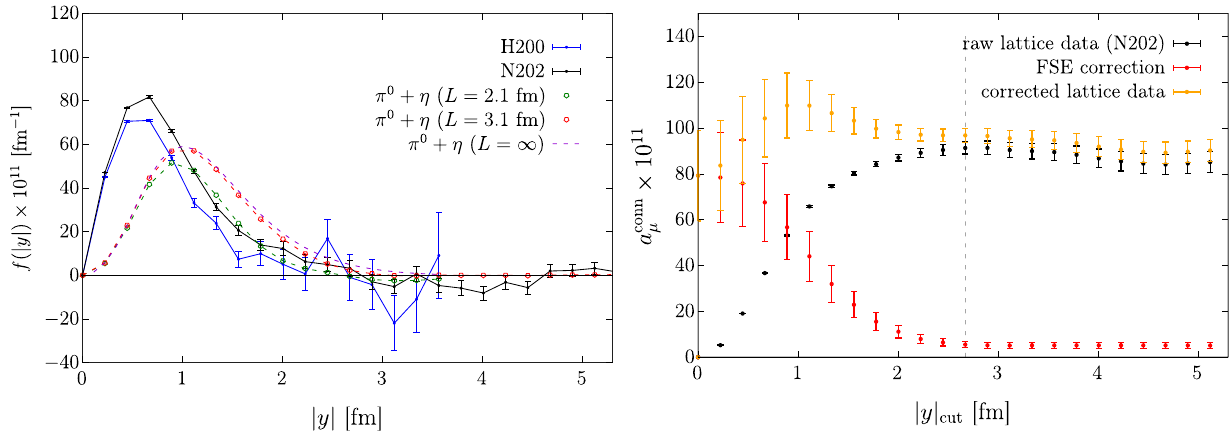
Fig. 11 Study of FSEs for method 2. Left: integrand for the ensembles H200 and N202 with m π L = 4 . 4 and 6 . 4 respectively. Right: value of a conn μ for the ensemble N202 using the FSE correction prescription described in the text, as a function of | y | cut